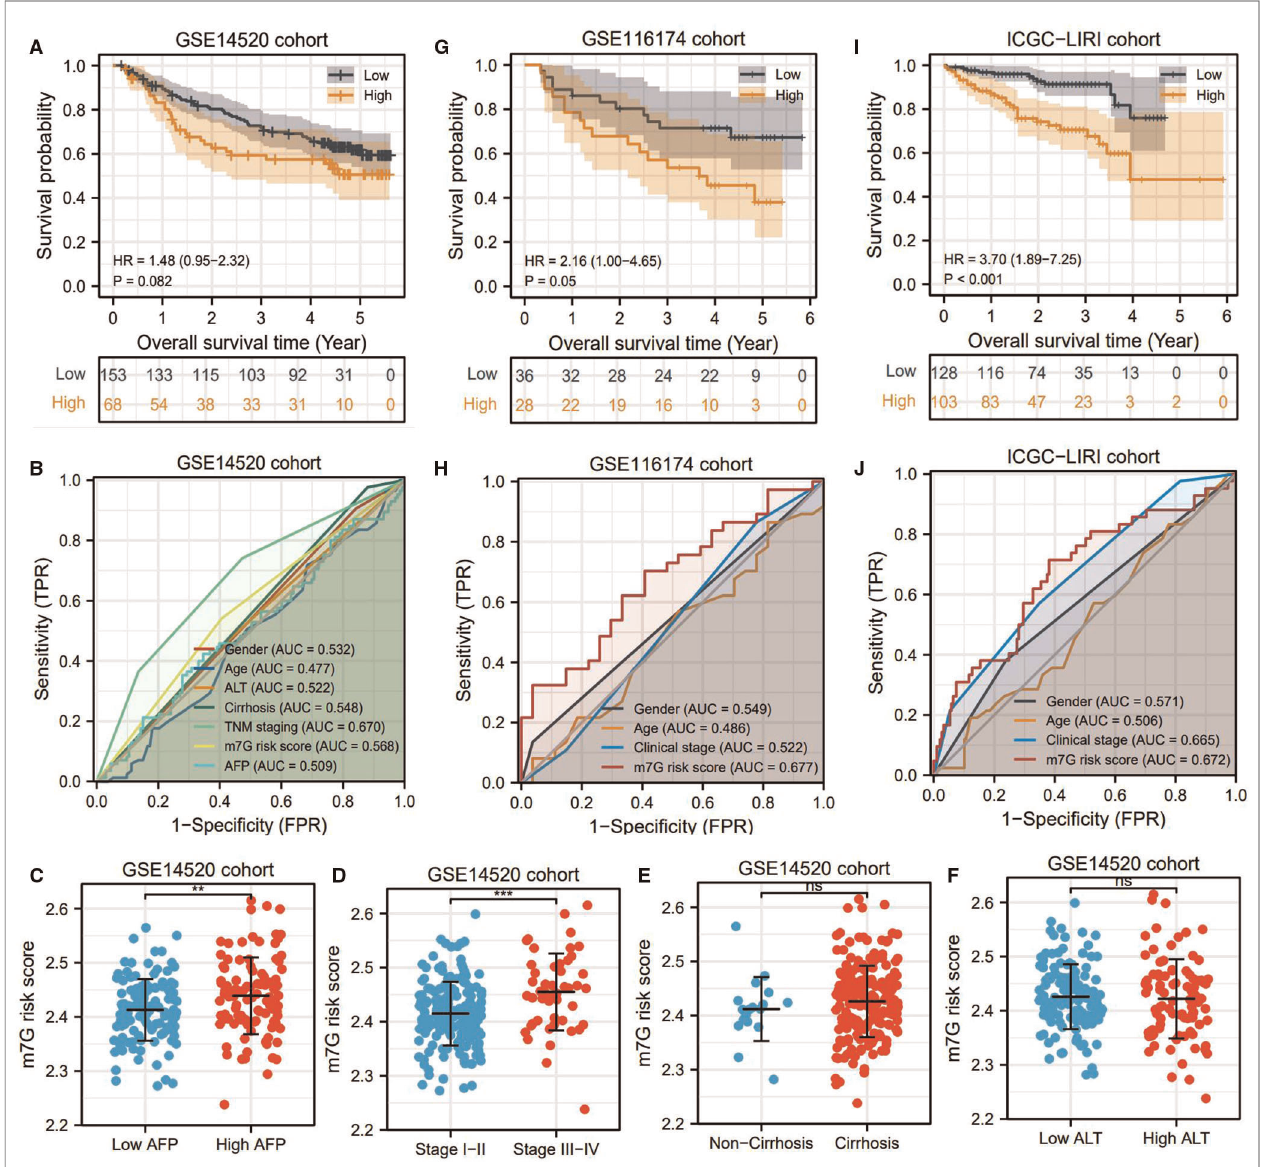
FIGURE 5 | m7G risk signature is successfully tested in validation cohorts. ( A,B ) Survival difference and ROC analyses in the GSE14520 cohort. ( C – F ) Differences in m7G risk scores between different clinical markers in the GSE14520 cohort. ( G,H ) Survival differences and ROC analyses in the GSE116174 cohort. ( I,J ) Survival differences and ROC analyses in the ICGC-LIRI cohort. * P <0.05, ** P <0.01, *** P